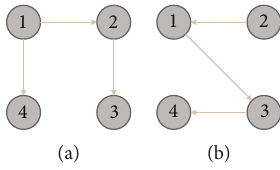
Figure 1: The jumping network topologies of